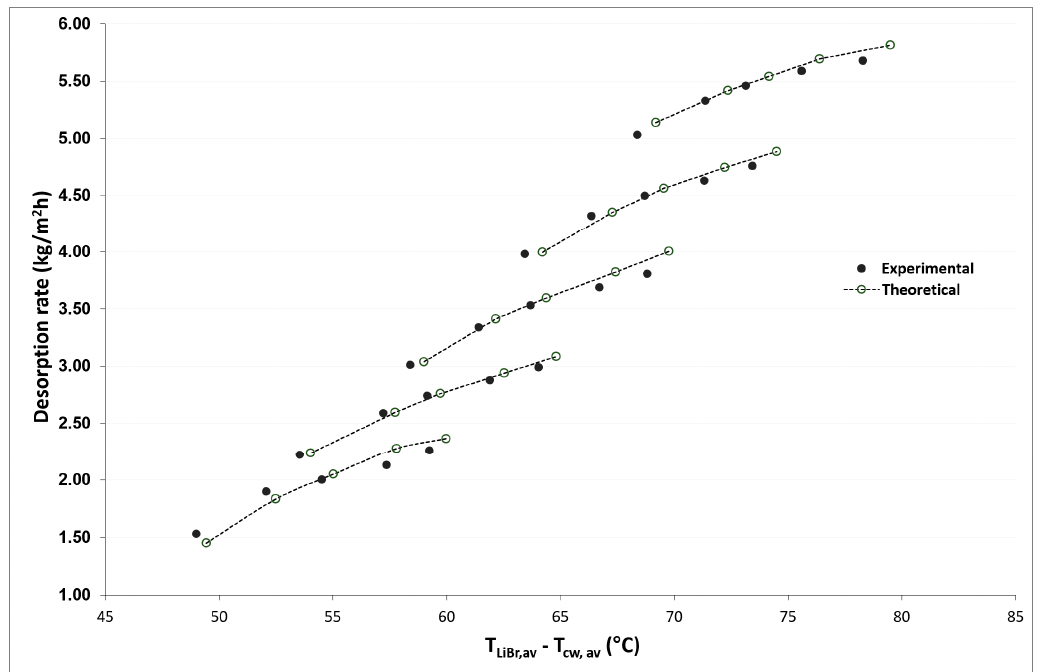
Figure 6. Desorption rate as a function of the average temperature difference between the hot feed solution and cooling water.